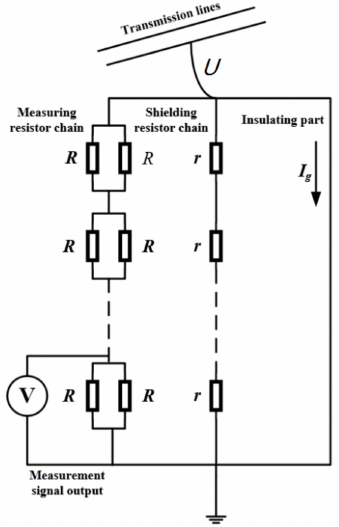
Figure 1. Basic structure diagram of the resistor divider.